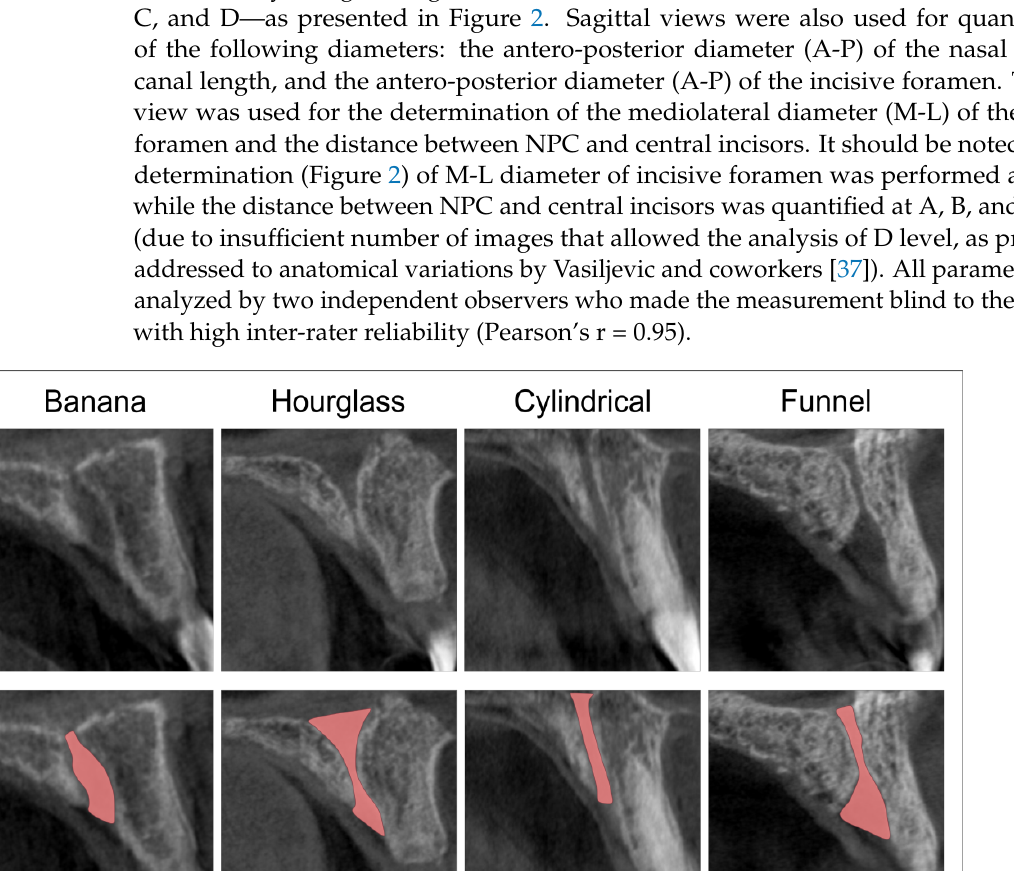
Figure 2. The definition of morphometric parameters of interest on CBCT images of the anterior maxilla. Sagittal cross-section; sagittal CBCT view with the marked field of interest ( left ); selected morphometric parameters for analyses ( right ): ( A ) the distance between the cortical layer of the incisive foramen and facial aspect of the buccal bone plate; ( B ) the distance between the cortical layer of the nasopalatine canal and facial aspect of the buccal bone plate using a horizontal line from the palatal border of the incisive foramen; ( C ) the distance between the cortical layer at the midpoint level of NPC length and facial aspect of the buccal bone plate; and ( D ) the distance between the cortical layer of the nasal foramen and facial aspect of the buccal bone plate. Axial cross-section; axial CBCT view: ( bottom ) the minimal interspace (i) between incisive foramen and central incisors at level A; ( middle ) the minimal interspace (i) between incisive foramen and central incisors at level B; (b) M-L diameter of incisive foramen; and ( upper ) the minimal interspace (i) between NPC and central incisors at level C. 2.4. Statistical Analysis All data obtained in this study were expressed (in mm) as means ± SEM. Following initial submission to Levene’s test for homogeneity of variance and to the Shapiro–Wilk